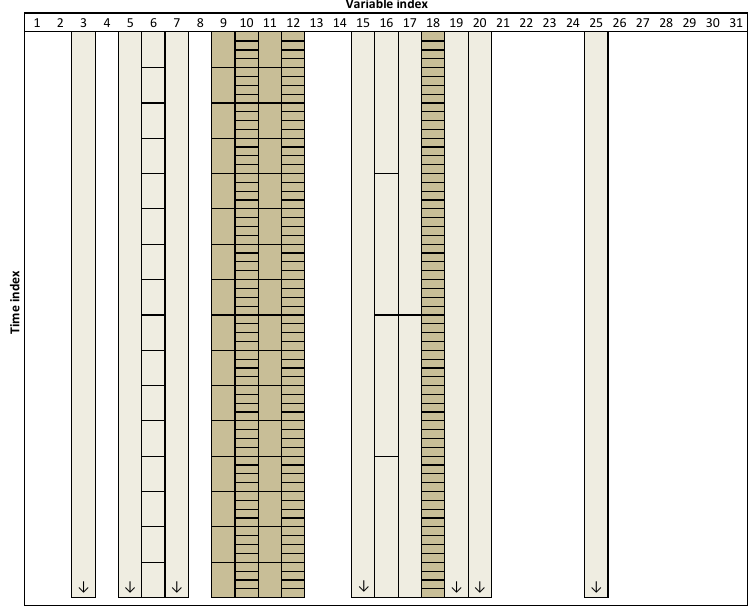
Figure 7. Schematic representation of the variables/resolutions selected for building the model. The size of the boxes represent the adopted granularity for each variable; the lighter shades indicate variable/resolutions that were pre-selected by the algorithm but discarded afterwards; the final combination of variables/resolution used in the model are represented with a darker color).